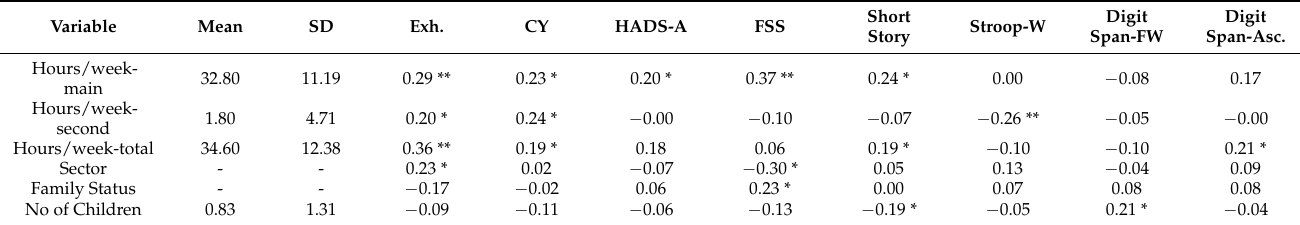
Table A3. Correlations between Demographics, MBI-GS, HADS, FSS and cognitive tasks ( n = 104).